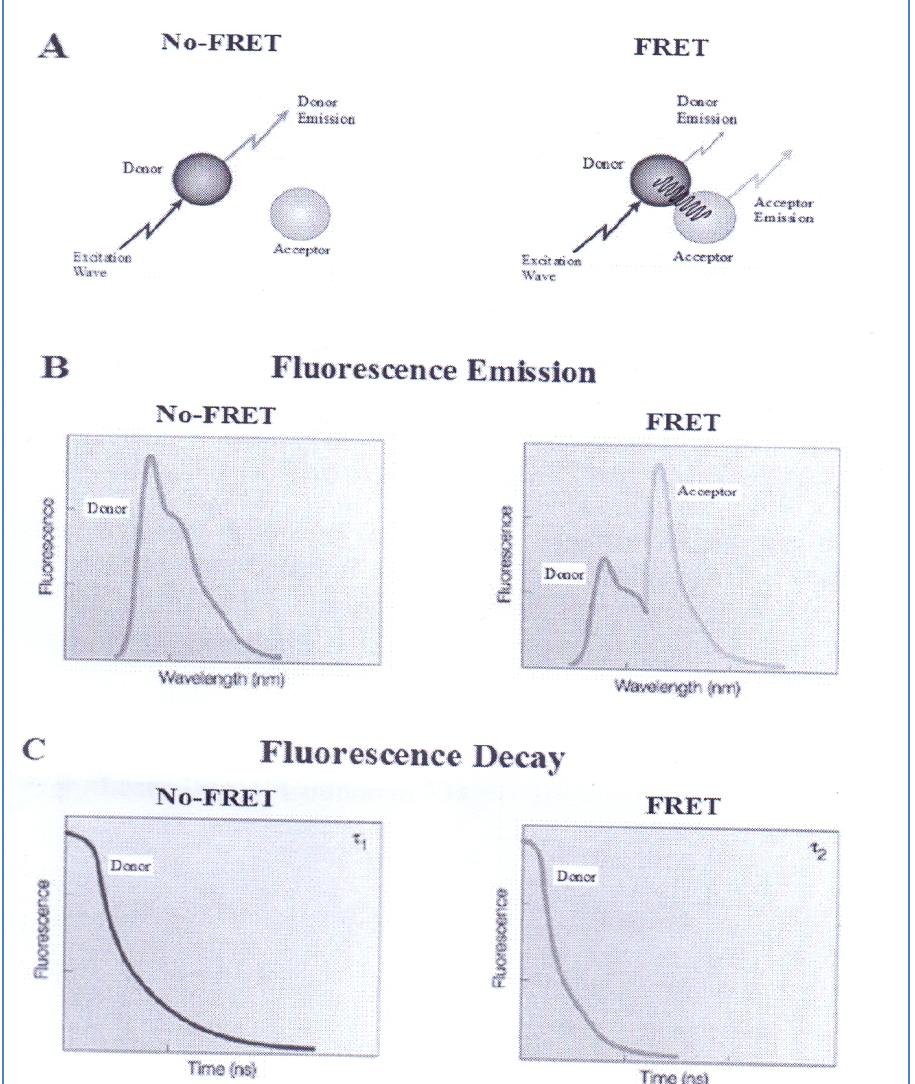
Fig. 1: Fluorescence emission and fluorescence decay spectra of (non-FRET) and (FRET) systems. (A): Donor and acceptor molecule interaction, (B): Fluorescence emission for (non-FRET) and (FRET), (C): Fluorescence decay for (non-FRET) and (FRET). Adapted from